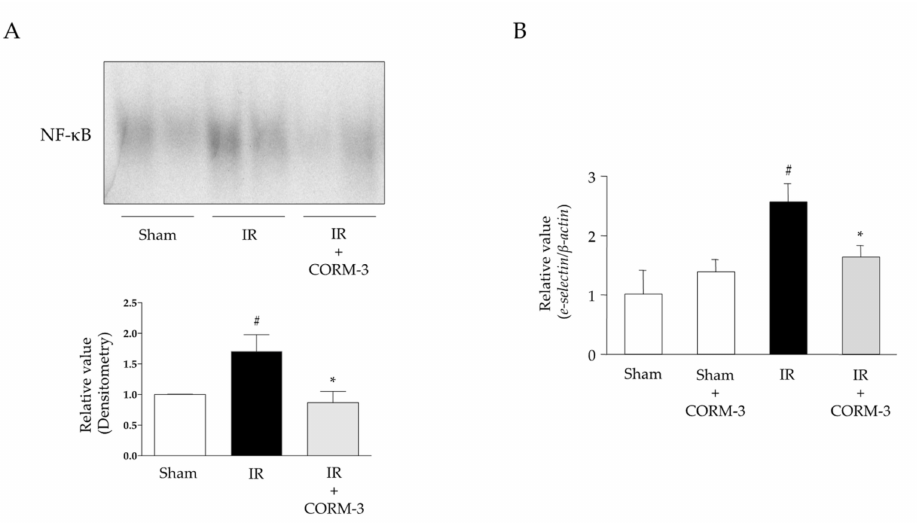
Figure 6. Effect of carbon monoxide-releasing molecule (CORM)-3 on the inflammatory response in intestinal IR injury. ( A ) Luminal protein (a Bio-Rad Protein Assay kit) ( n = 7) and ( B ) luminal hemoglobin levels (a Hemoglobin-Test-Wako kit) ( n = 7). ( C ) Representative histological appearance in the intestinal tissues (hematoxylin and eosin stain; × 20). ( D ) MPO activity (MPO assay) ( n = 7), ( E ) tissue TNF- α protein levels, and ( F ) tissue KC protein levels (eBioscience ELISA) ( n = 7). Sham operation or intestinal IR injury with or without CORM-3 administration was induced in the wild-type mice. Each value represents the mean ± SEM. # p < 0.05 compared with sham-operated WT mice; * p < 0.05 compared with IR-induced WT mice.